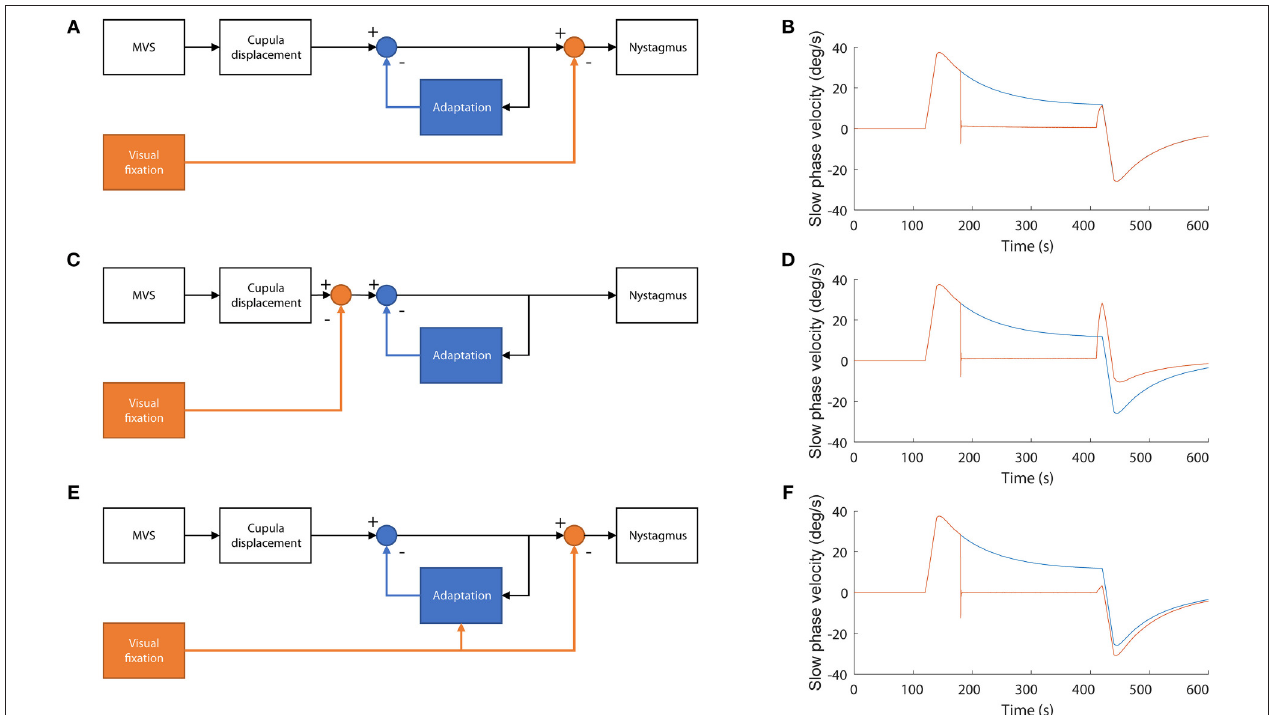
FIGURE 5 | Simulations of alternative models of the interaction between adaptation and the cancellation of nystagmus by visual fixation. (A,B) Visual information is used to cancel nystagmus at a stage of processing later than adaptation. In this model adaptation is not affected by the presence of visual fixation while in the MRI. This simulation accords best with our data (C,D) Visual information is used to cancel the nystagmus at a stage before adaptation occurs. In this case, no adaptation occurs during fixation and thus the after effect is smaller, only due to the initial first minute of adaptation in darkness, (E,F) Visual information is used to cancel nystagmus after adaptation occurs but also to enhance adaptation. In this case, adaptation is stronger, and the after effect is